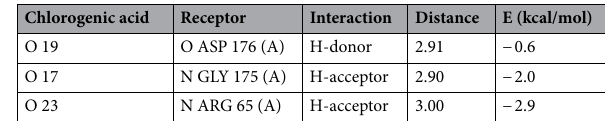
Table 6. Chlorogenic acid interaction with 1HZO protein.